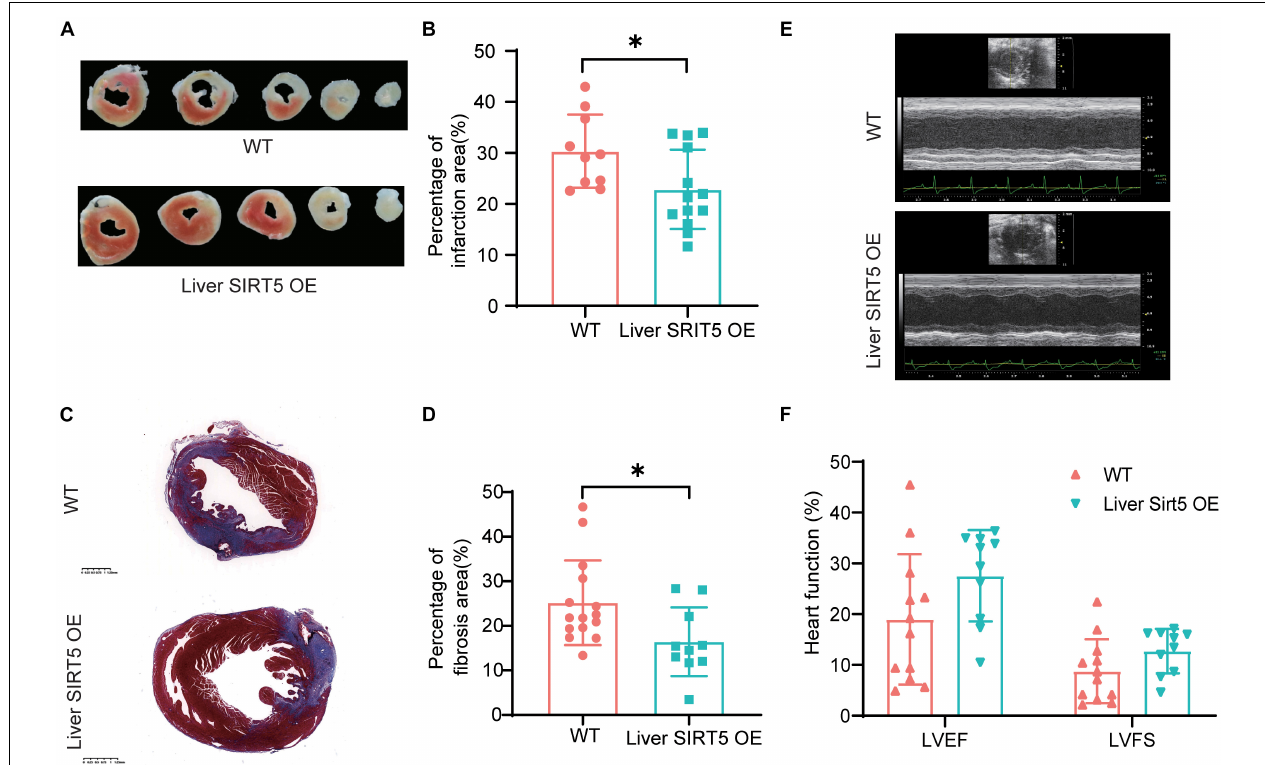
FIGURE 2 | Comparation of infarction area between Liver SIRT5 OE and WT mice after AMI. (A) Representative images of triphenyltetrazole chloride (TTC) staining 5 days after AMI between Liver SIRT5 OE and WT mice ( n = 6). (B) Comparation of infarction area 5 days after AMI between Liver SIRT5 OE and WT mice ( n = 6). * p < 0.05. (C) Representative images of Masson staining 5 days after AMI between Liver SIRT5 OE and WT mice ( n = 6). (D) Comparation of fibrosis area 5 days after AMI between Liver SIRT5 OE and WT mice ( n = 6). * p < 0.05. (E) Representative images of echocardiography 4 days after AMI between Liver SIRT5 OE and WT mice ( n = 6). (F) Comparation of heart function 4 days after AMI between Liver SIRT5 OE and WT mice ( n =